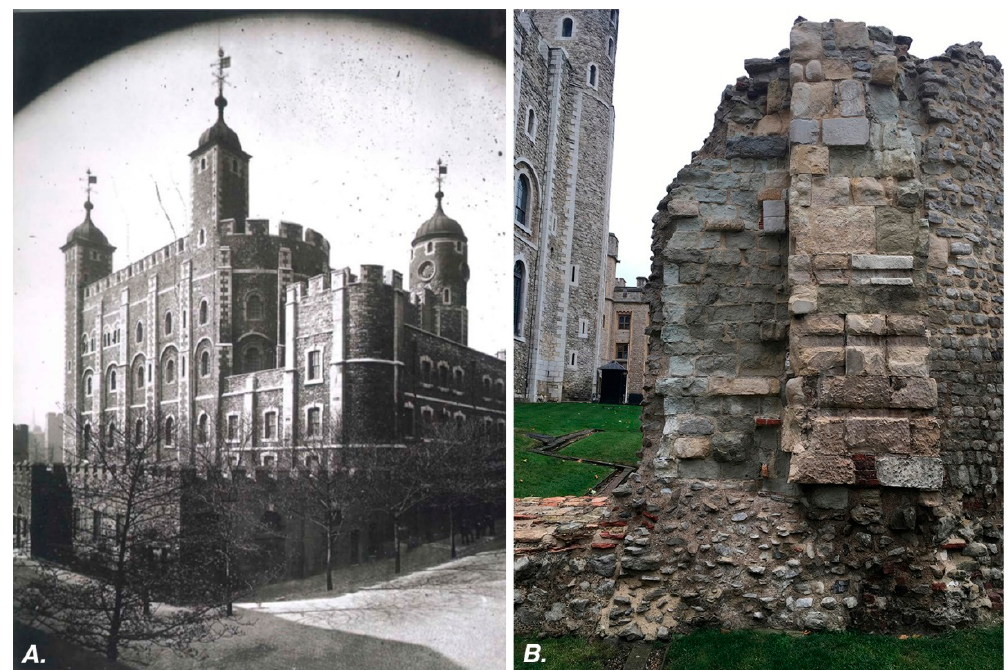
Figure 1. ( A ) Extent of late- and post-medieval auxiliary construction surrounding White Tower (main building) and Wardrobe Tower (foreground). Photo from south-east c.1870 (HRP archives). ( B ) Present-day condition of Wardrobe Tower, following 2017 conservation work, viewed from south. Photo November 2017 (Authors own).